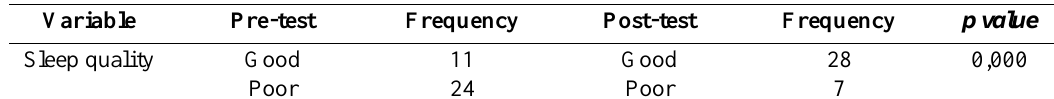
Effect of giving massage to sleep quality after giving massage in a Kindergarten in Lawang